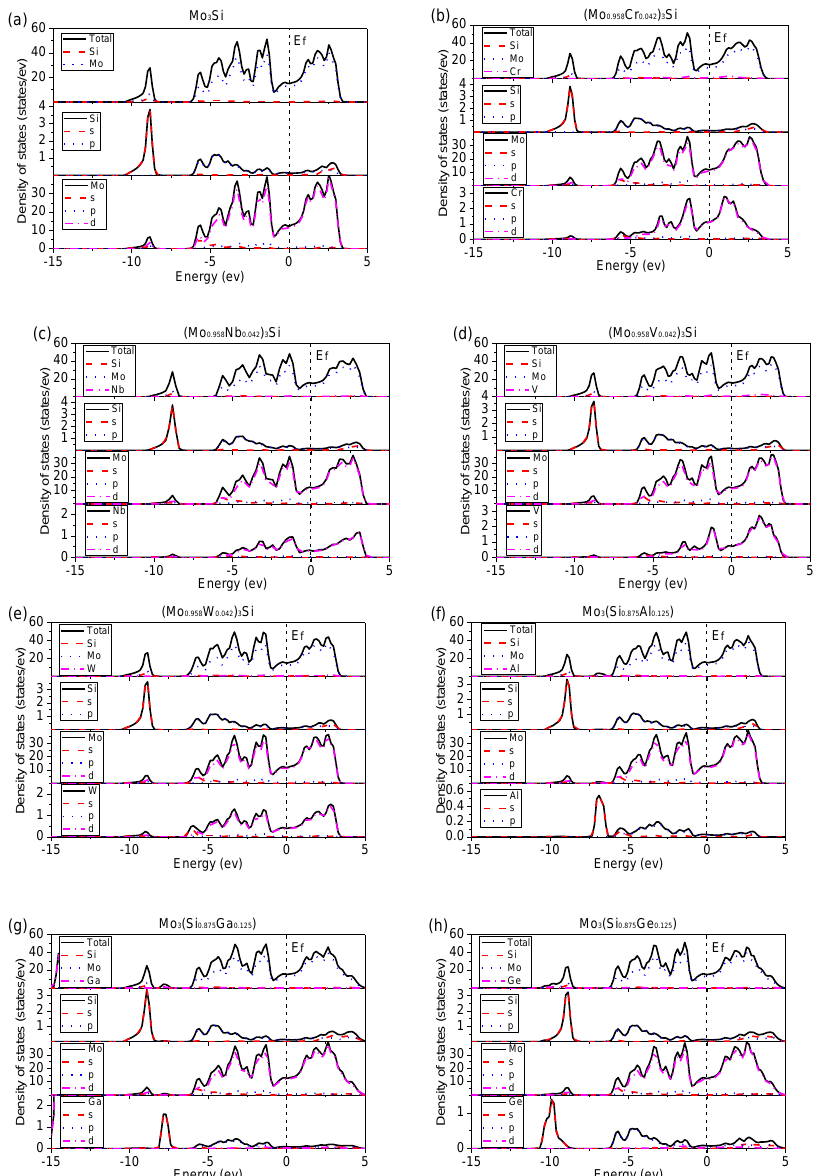
Figure 10. Density of states ( DOS) of undoped and doped Mo 3 Si. ( a ) Mo 3 Si; ( b ) (Mo 0.958 Cr 0.042 ) 3 Si; ( c ) (Mo 0.958 Nb 0.042 ) 3 Si; ( d ) (Mo 0.958 V 0.042 ) 3 Si; ( e ) (Mo 0.958 W 0.042 ) 3 Si; ( f ) Mo 3 (Si 0.875 Al 0.125 ); ( g ) Mo 3 (Si 0.875 Ga 0.125 ); ( h ) Mo 3 (Si 0.875 Ge 0.125 ).